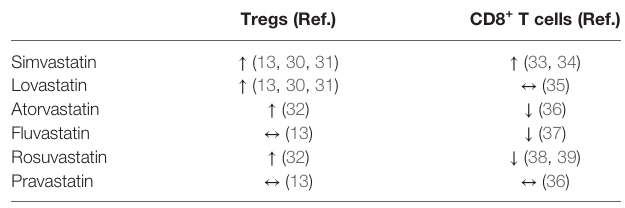
TABLE 1 | The effect of several statins on Tregs and CD8 + T cells. Tregs